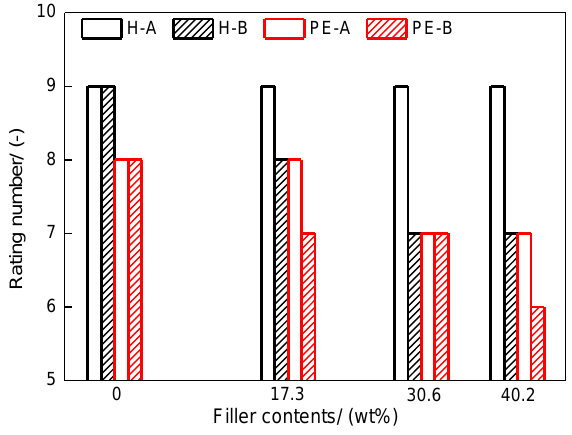
Figure 13. Time consumed of samples at 90% of gloss retention.